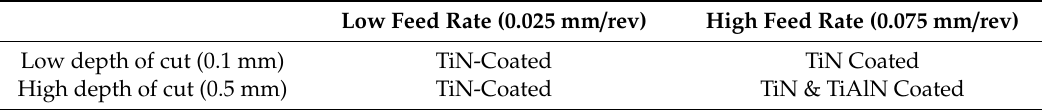
Table 3. Tool surface finish best performance summary.